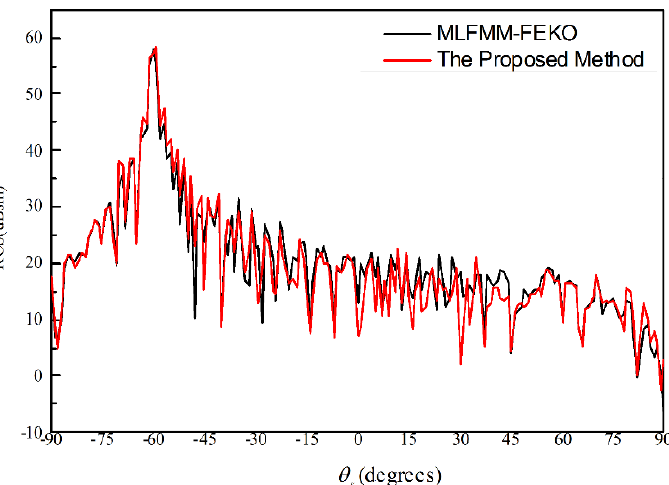
Figure 4. The bistatic scattering from two missile − like targets above the electrically large rough sea surface.